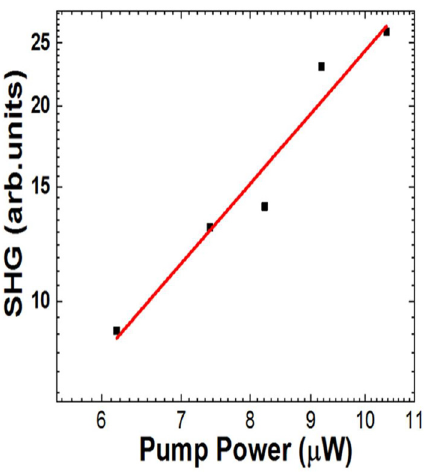
Figure5: Excitationpowerdependence.Thefundamentalexcitation is y -polarization at resonant wavelength of 1360 nm and the SHG emission was detected for x -polarization at 680 nm.